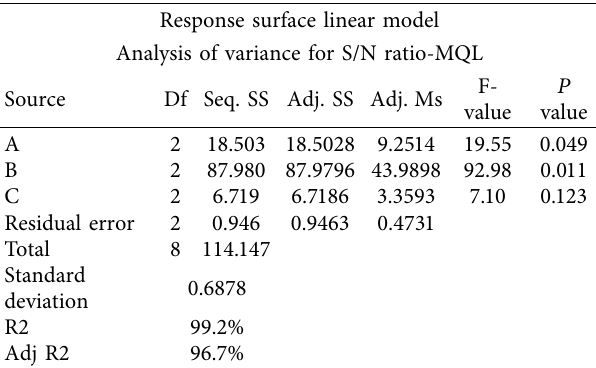
Table 4: ANOVA for S/N ratios ( R